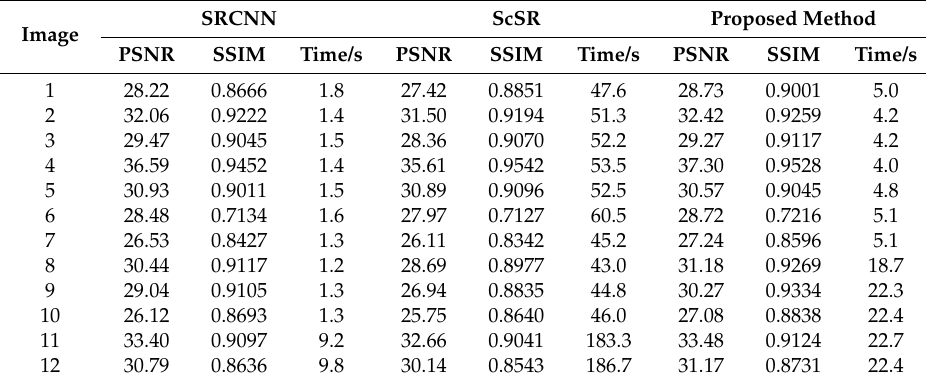
Table 2. SR results with upscaling factor of